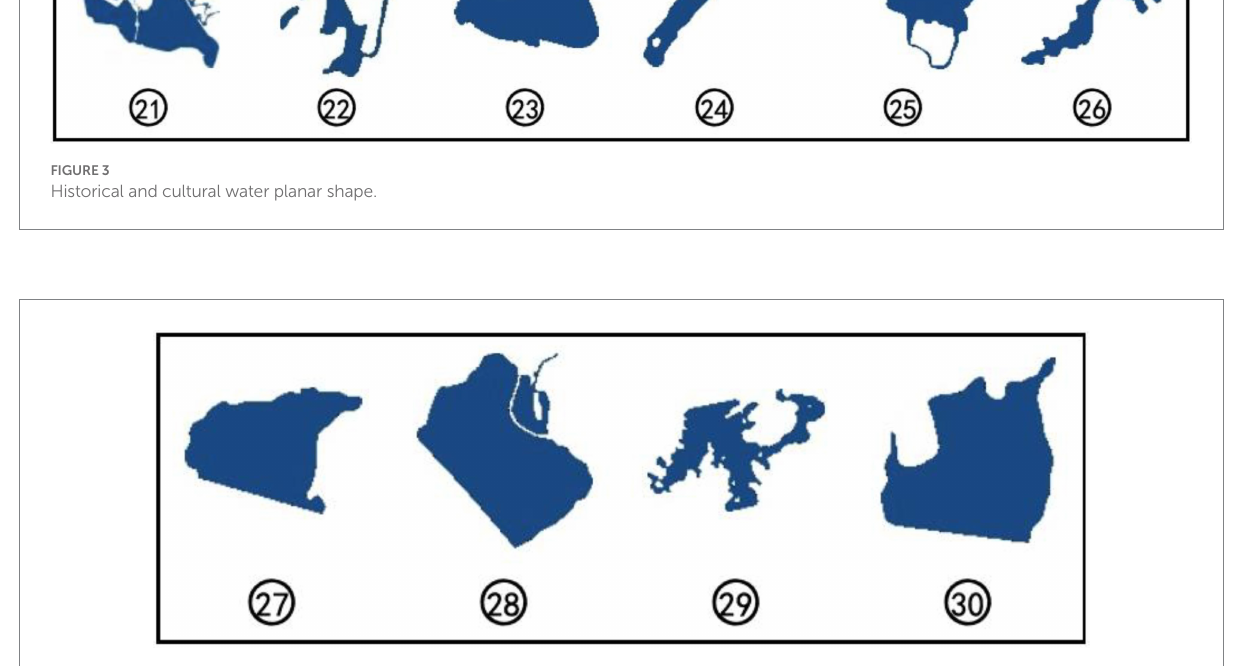
FIGURE 4 Planar shape of ecological landscape water